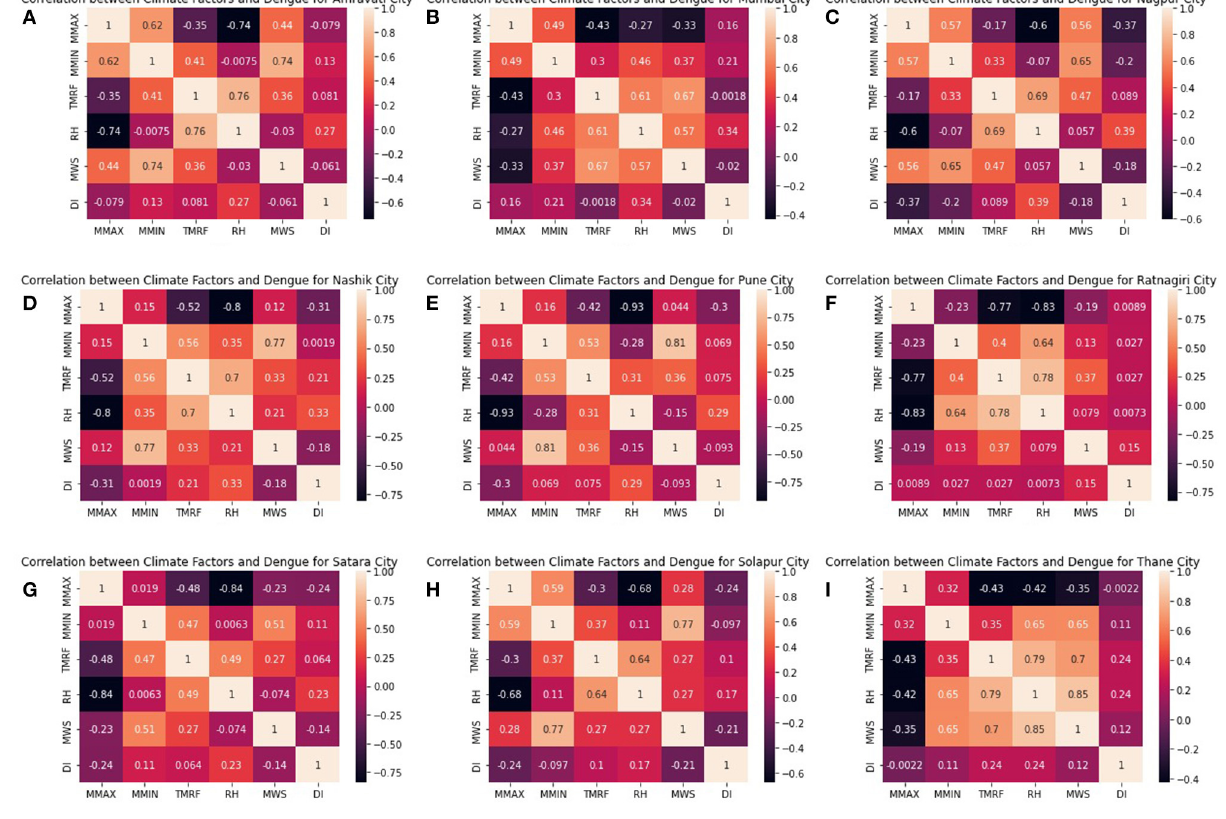
FIGURE 6 | Correlation of monthly mean minimum temperature, mean maximum temperature, total monthly rainfall, relative humidity, mean wind speed climate parameters, and monthly dengue incidences: (A) Amravati, (B) Mumbai, (C) Nagpur, (D) Nashik, (E) Pune, (F) Ratnagiri, (G) Satara, (H) Solapur, (I)